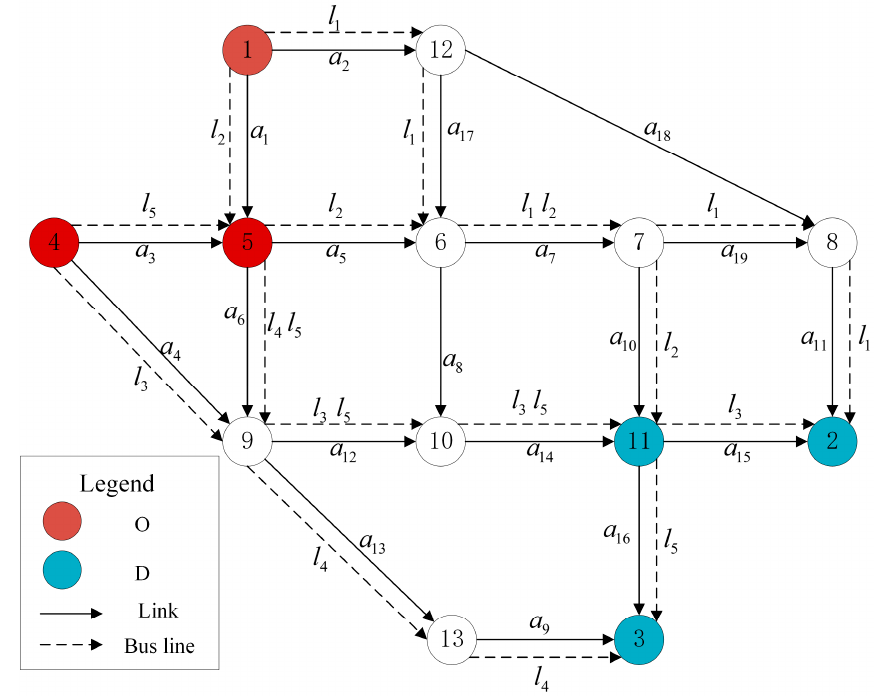
Figure 6. Traffic network.